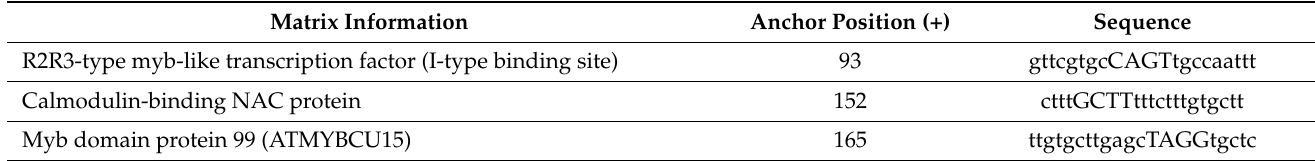
Table 1. Stress-associated cis -element families present on the promoter sequence, their position and motif